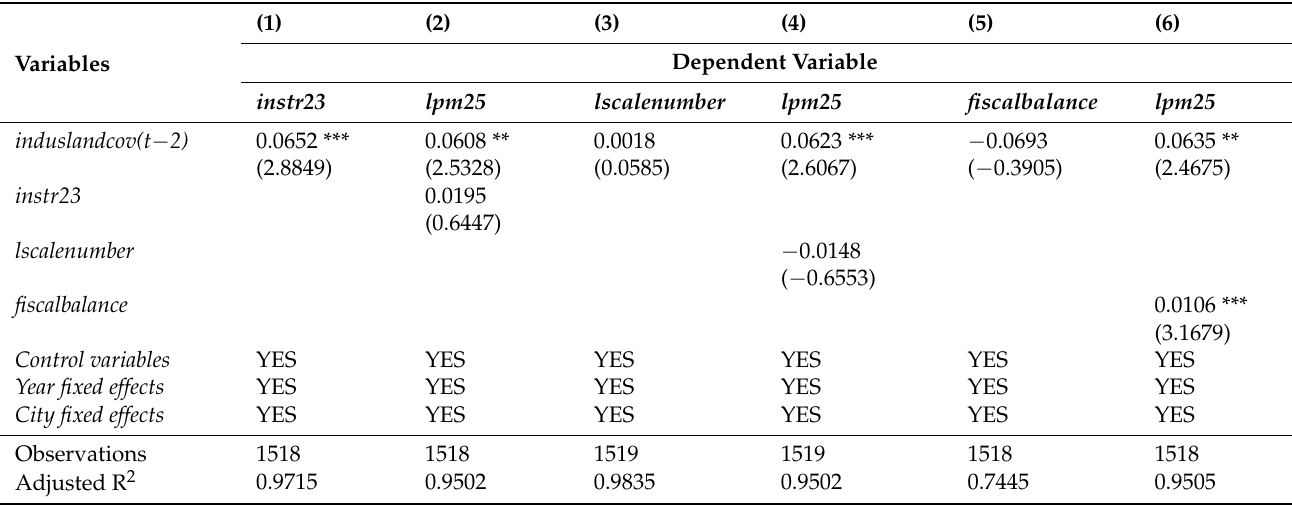
Table 7. Mechanism